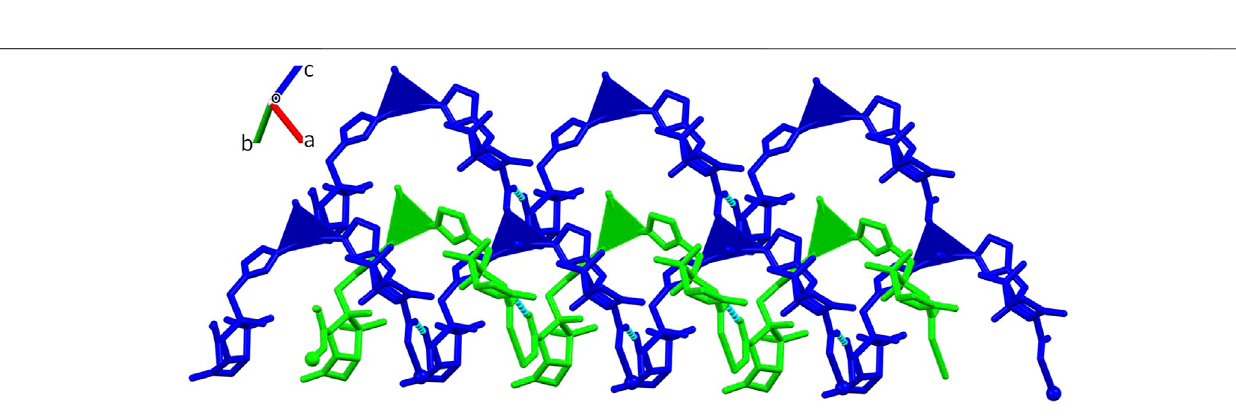
FIGURE 6 | Crystal packing of [Ag(I)-Tazo 2 ] depicting the 2D (blue) and 1D (green) coordination networks.